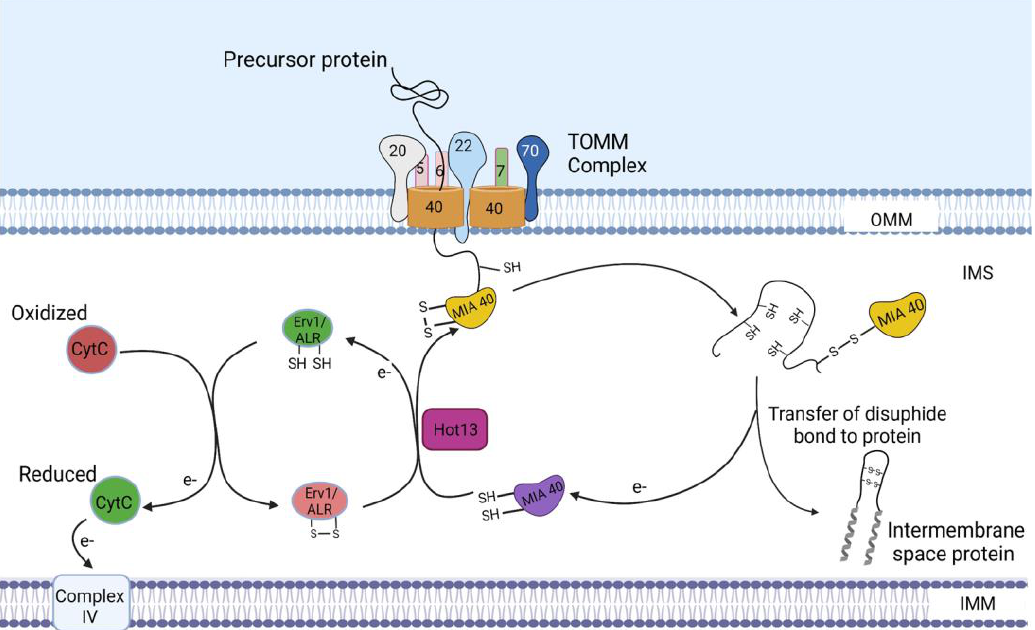
Figure 4. Import of intermembrane space proteins. As the precursors pass through the TOMM40 channel, the IMS sorting signals of these precursors are recognized by MIA40. Thereafter, MIA40 binds the precursors and facilitates their entry into the IMS. The imported precursors are oxidized by the oxidoreductase activity of MIA40, after which they are assembled in the IMS. In turn, MIA40 becomes reduced and is reoxidized by Erv1/ALR with the assistance of the zinc-binding protein– Helper of Tim protein 13 (Hot13). Electrons derived from the oxidation of the imported precursors by MIA40 are transferred to Erv1/ALR and, subsequently, to cytochrome C and complex IV. IMS, intermembrane space; Erv1, essential for respiration and viability 1 protein; ALR, augmenter of liver regeneration. The figure was created with Biorender.com.